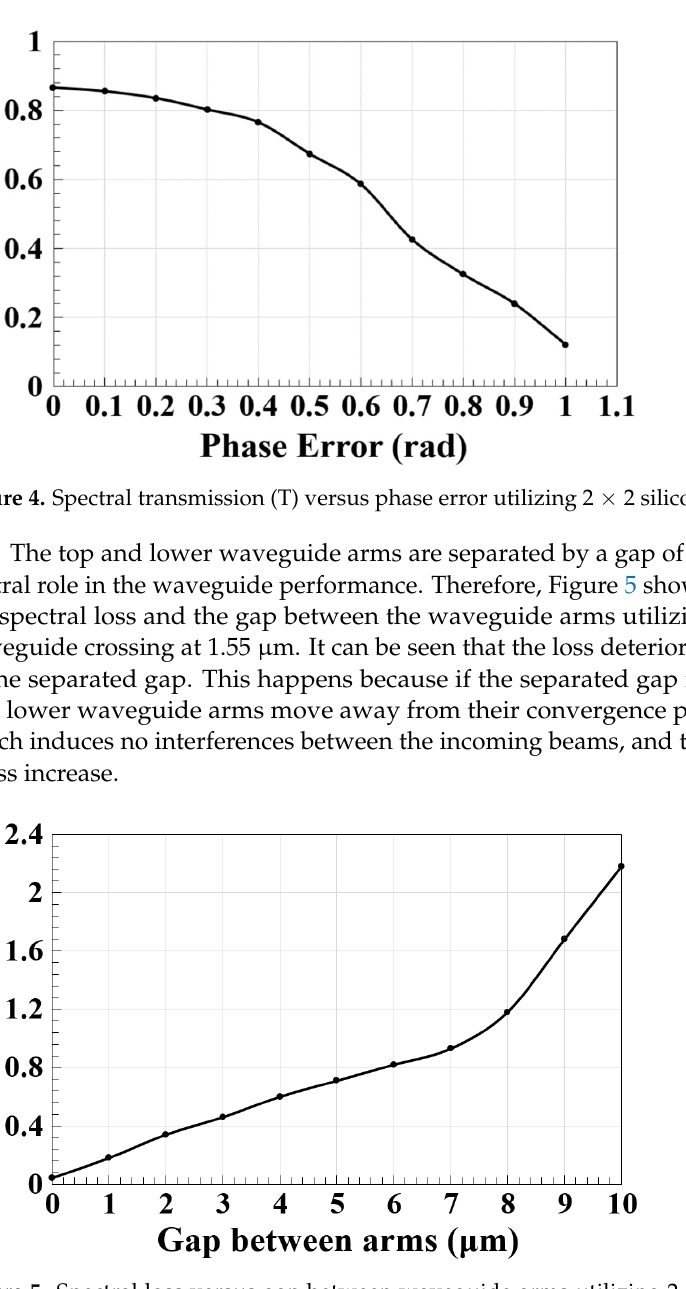
Figure 5. Spectral loss versus gap between waveguide arms utilizing 2 × 2 silicon waveguide at 1.55 μ m.